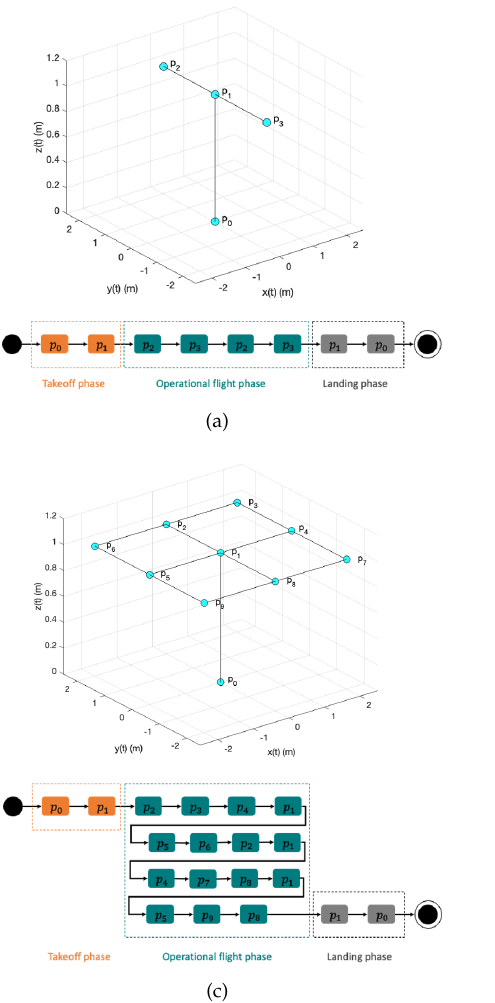
Figure 10. Concrete-level movements. ( a ) First movement: forward–backward. ( b ) Second movement: plus sign. ( c ) Third movement: square array.